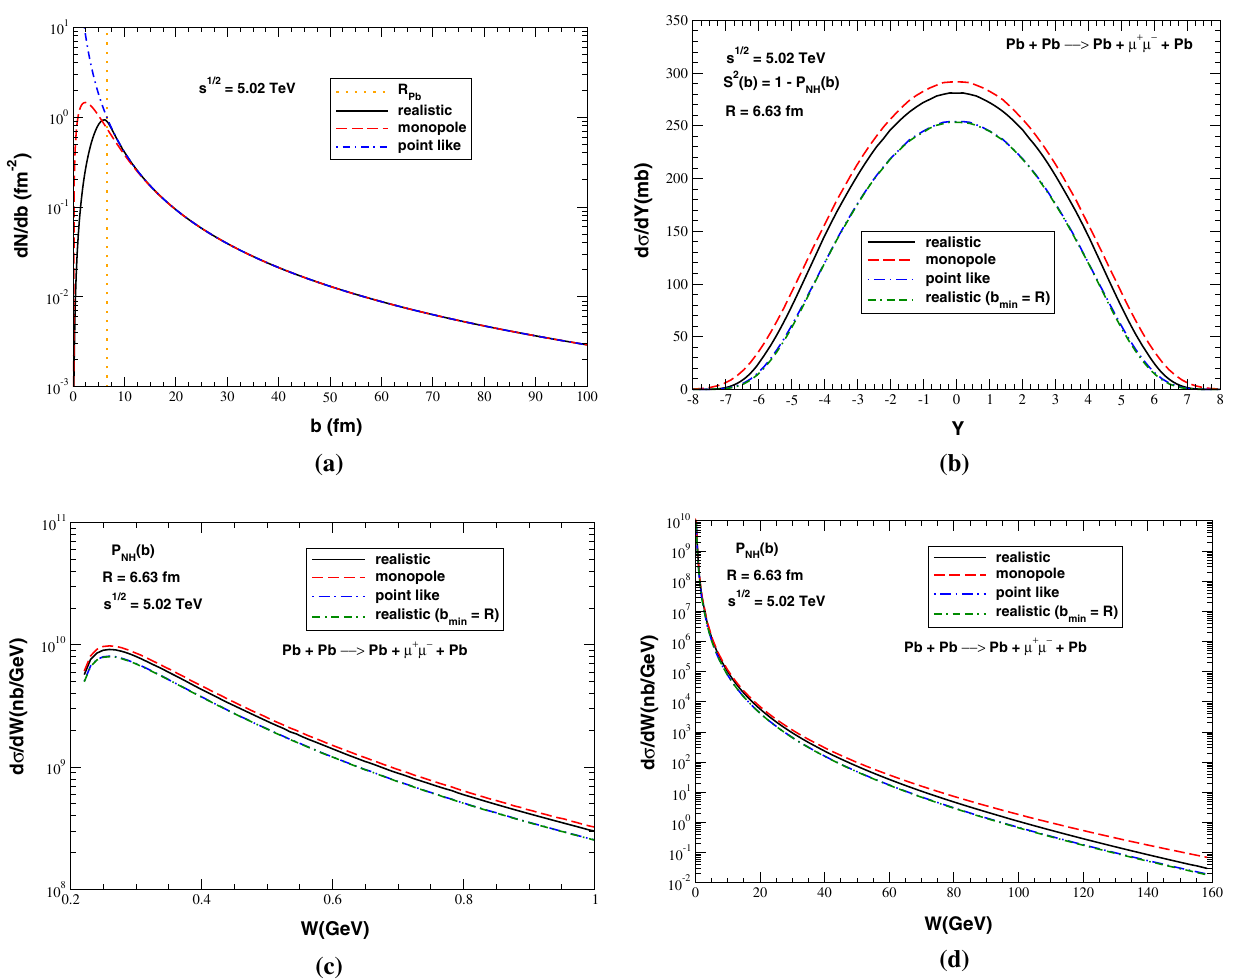
Fig. 3 a Impact parameter dependence of the equivalent photon flux, models for nuclear form factor F ( q ) , c invariant mass distribution of b rapidity distribution for the exclusive dimuon production by γγ inter- the dimuons predicted by the different models of F ( q ) , d idem for a √ s = 5 . 02 TeV considering the different actions in PbPb collisions at large invariant mass